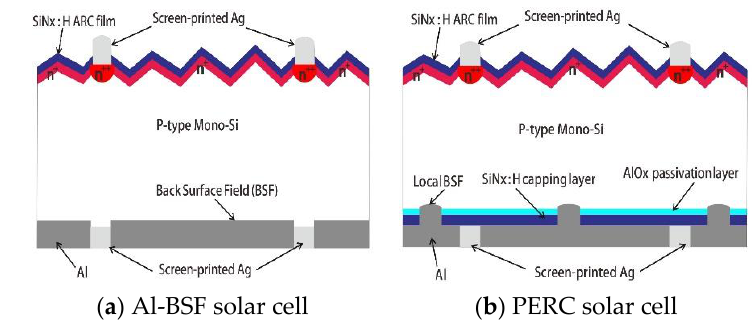
Figure 1. Schematic structures of an Al-BSF solar cell ( a ) and a PERC solar cell ( b ).